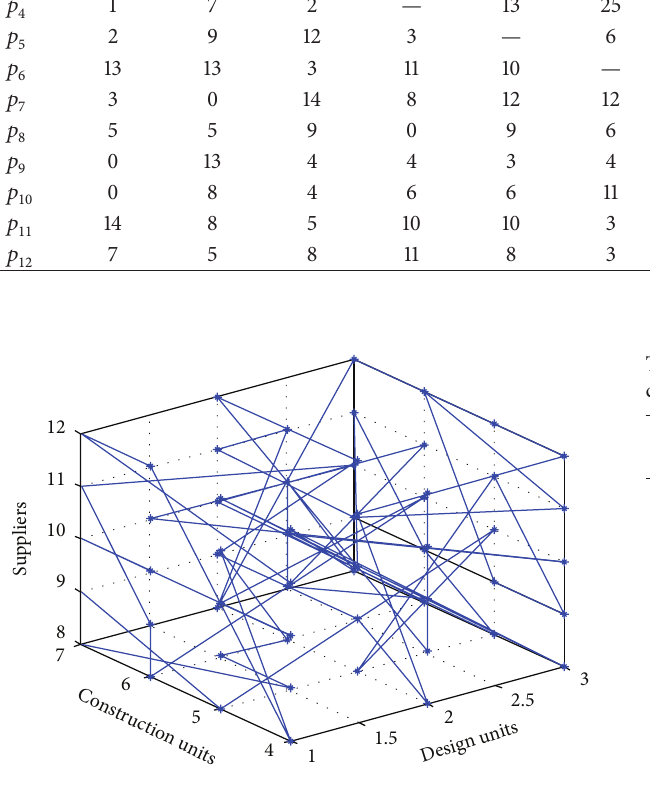
Figure 8: Case 2 : selection schemes of design units, construc-